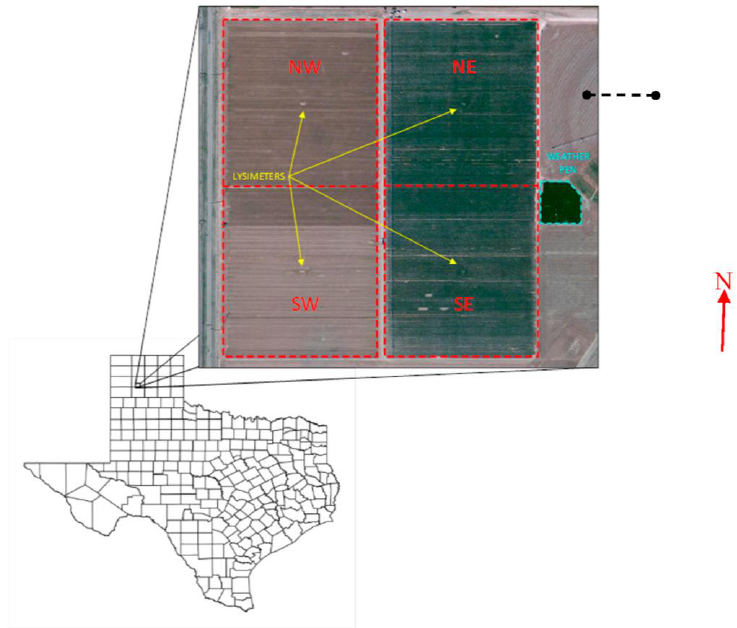
Figure 1. The study location with placement of large weighing lysimeters at the centers of four square fields at the USDA-ARS Conservation and Production Research Laboratory, Bushland, TX. The research weather pen is shown adjacent to the east side of the east lysimeter fields. The dashed black line in the NE field illustrates the path of the scintillometer radiation.